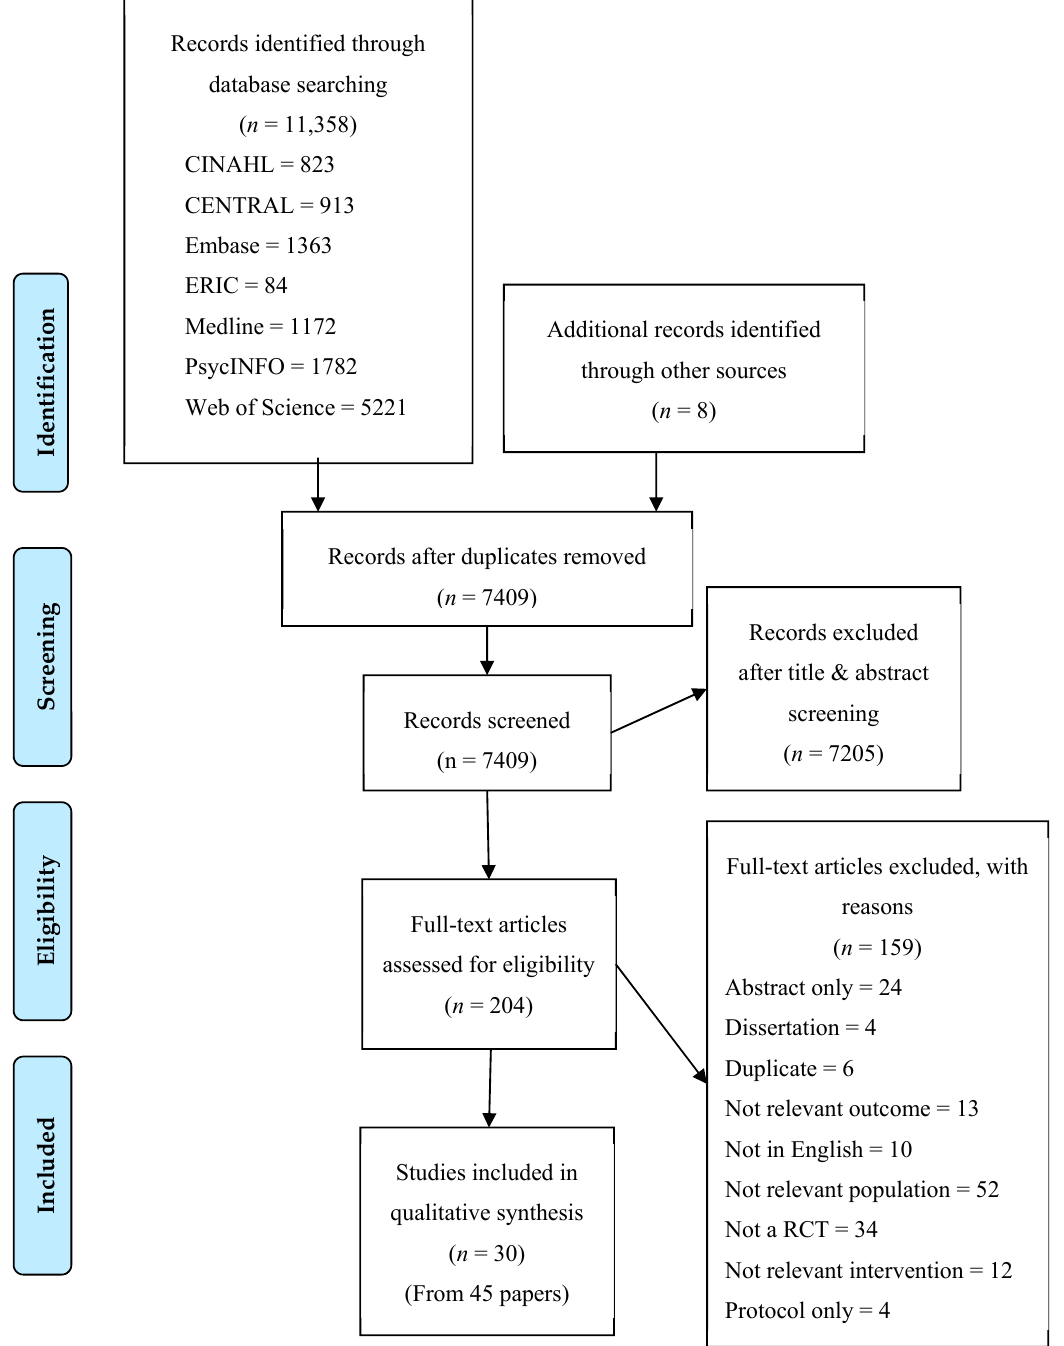
Figure 1. Preferred Reporting Items for Systematic Reviews and Meta-Analyses (PRISMA) flow chart for the search and filtering results for a systematic review of the effectiveness of prevention interventions for adolescents from racial and ethnic minorities.